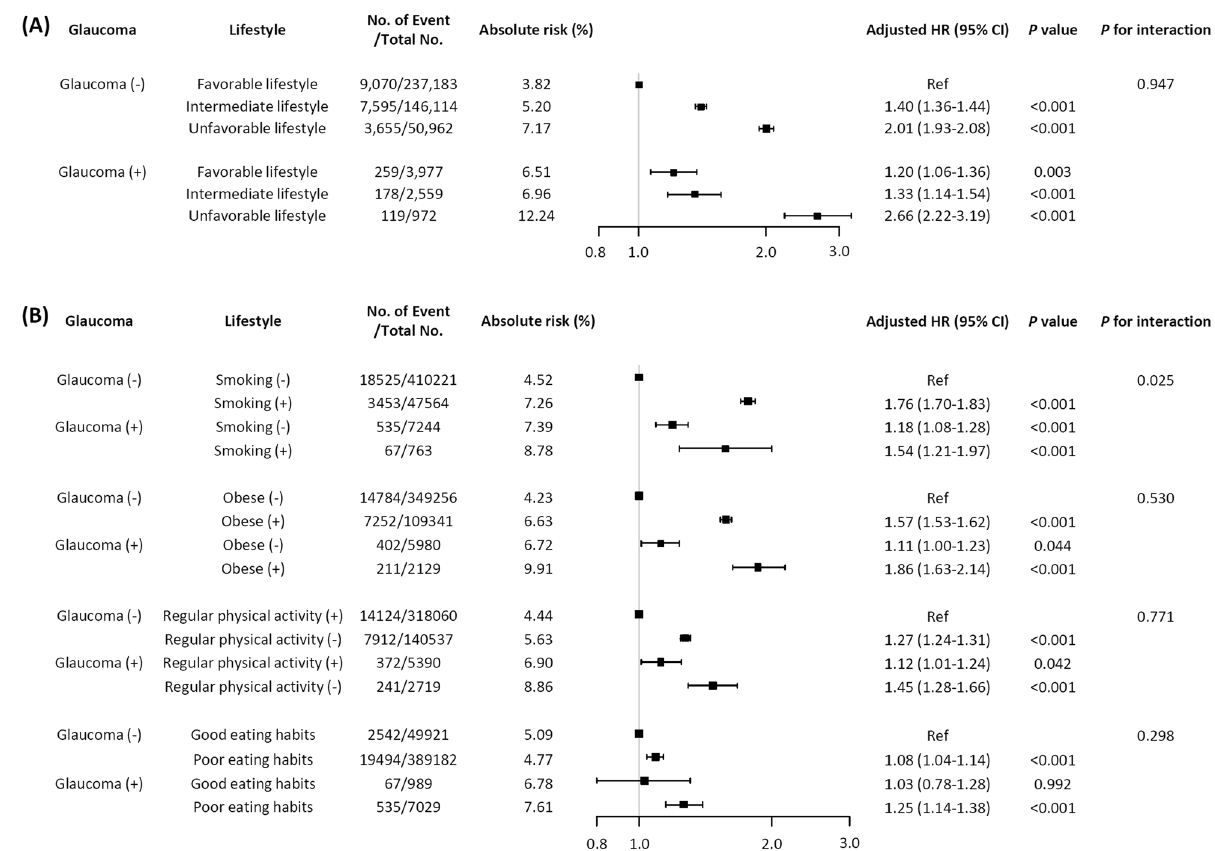
Figure 1. Forest plot for cardiovascular disease according to the presence of glaucoma and ( A ) lifestyle behavior, ( B ) smoking, obesity, physical activity, and eating habits. Results are shown after adjusting for age, sex, and